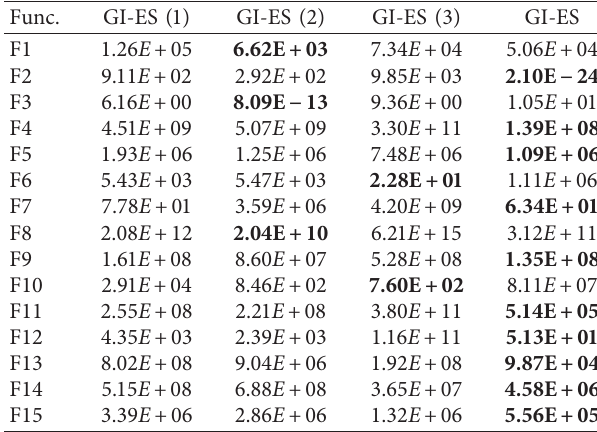
A LGORITHM 1: GI-ES. Table 1: Mean values of GI-ES and three component names GI-ES (1), GI-ES (2), and GI-ES (3) on